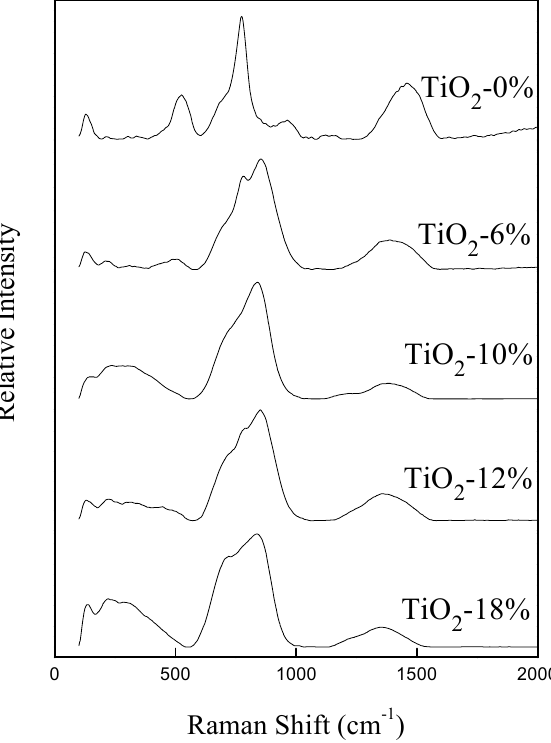
Figure 3. Raman spectra for samples with different con- tents of TiO 2 (No. 1, 2, 3, 4 and 5) at room temperature, after background subtraction.